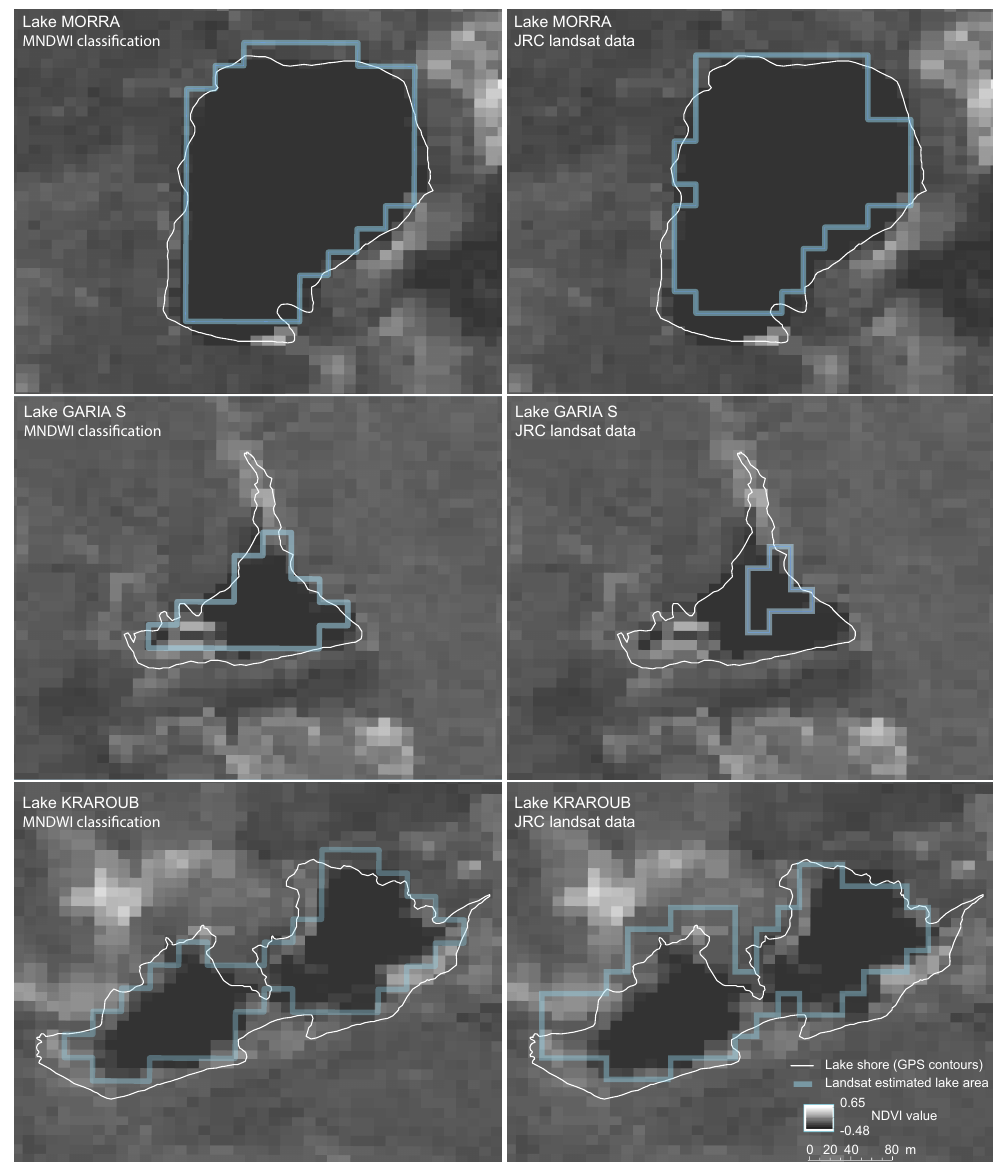
Figure 9. Comparison of surface water classification from the MNDWI approach and JRC data against DGPS contours and SPOT 5 NDVI maps for three lakes in May